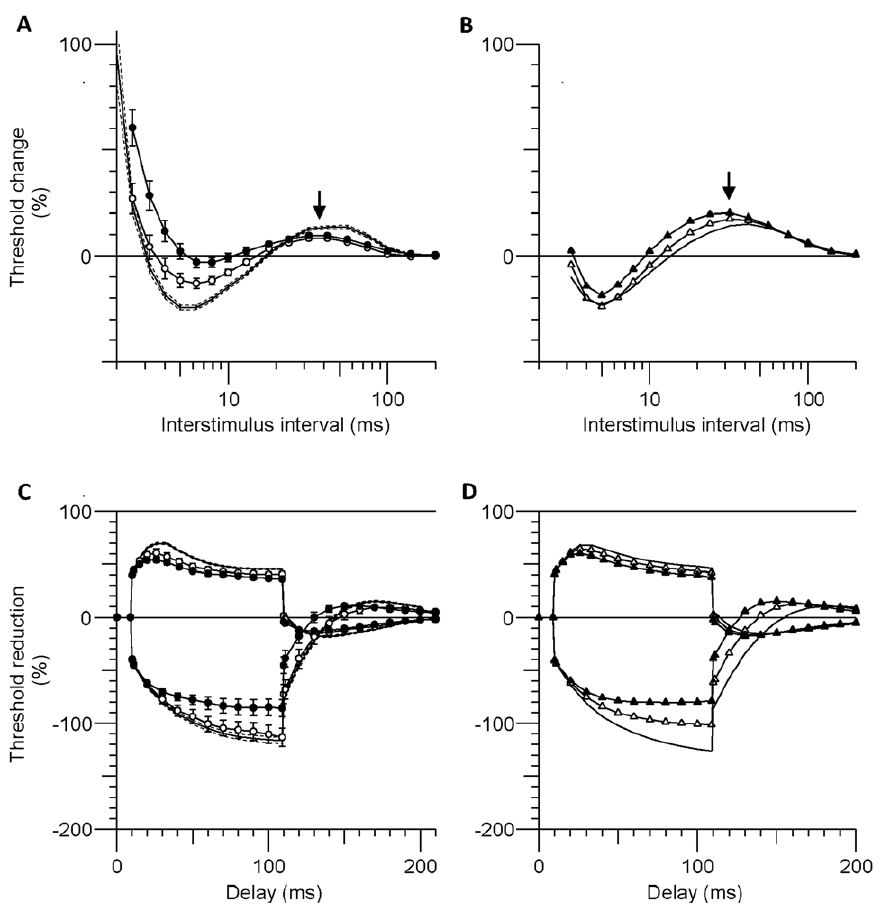
Figure 4. Mathematical model of depolarized axons. The observed excitability (mean 6 SEM) is shown in panels (A) and (C) comparing HFHD patients (filled circles) and HDF (empty circles) to the healthy controls (solid and dashed lines). Panels (B) and (D) compare the modelled excitability of a healthy human motor axon (solid line) to the same model with: [K + ] o increased to 5.3 mmol/L (empty triangles); and with [K + ] o =5.3 mmol/L and resting membrane potential further depolarized by 1 mV (filled triangles). The model provides a good fit to the changes in the threshold electrotonus data (C,D) but not the recovery cycle (A,B), particularly the extent of the changes in the refractory period, superexcitability and late subexcitability. Late subexcitability increased in the model (arrow in B) and decreased in the ESKD patients (arrow in